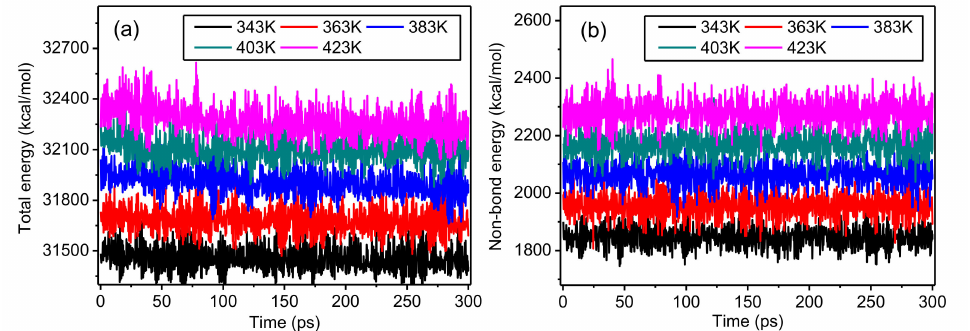
Figure 8. Changes of ( a ) total energy and ( b ) non-bond energy during the simulations at different temperatures.